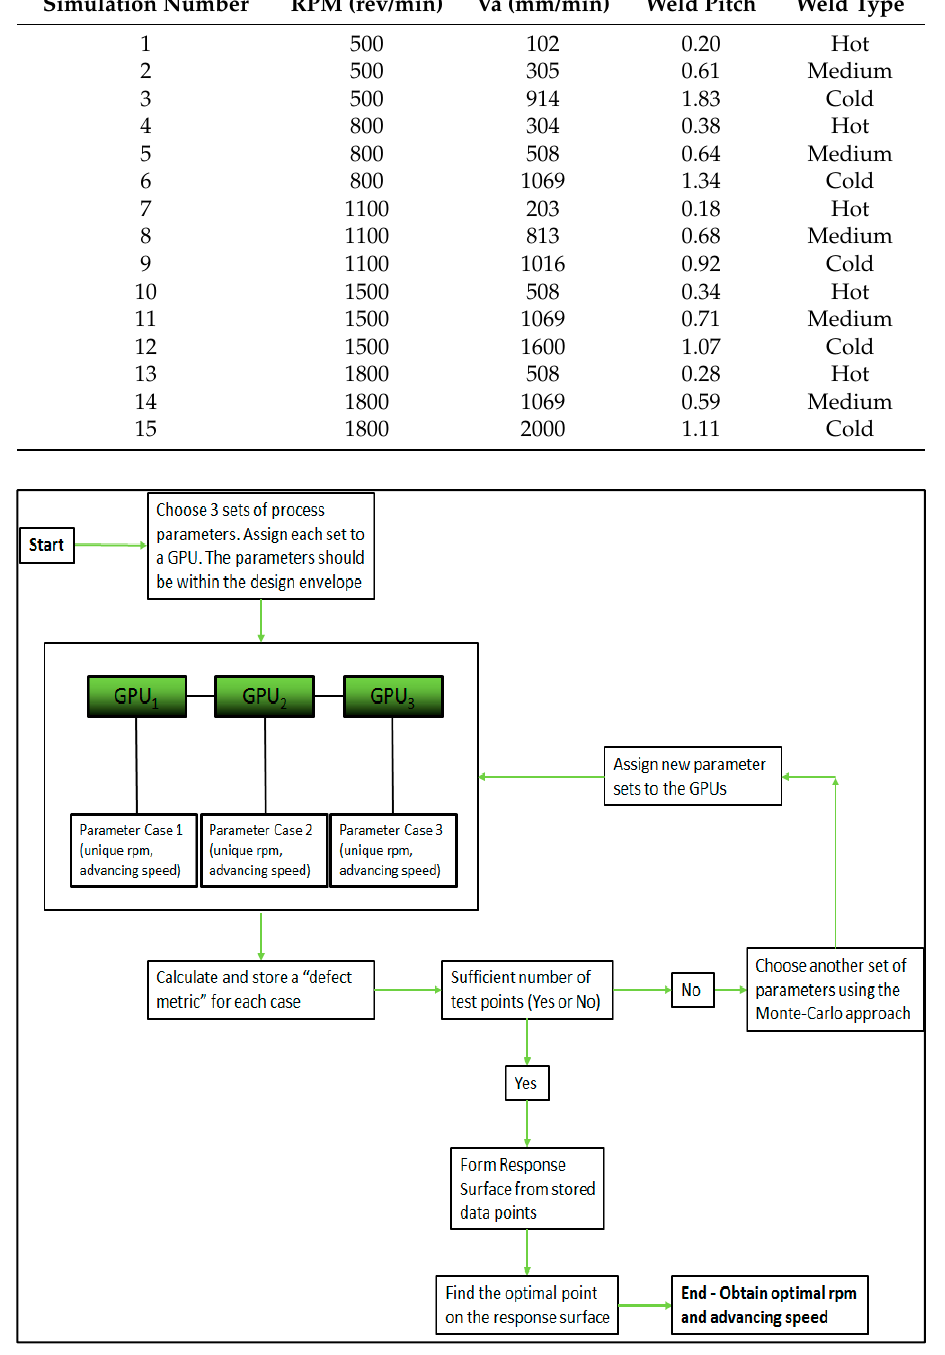
Figure 5. Optimization procedure with three graphics-processing units (GPUs).